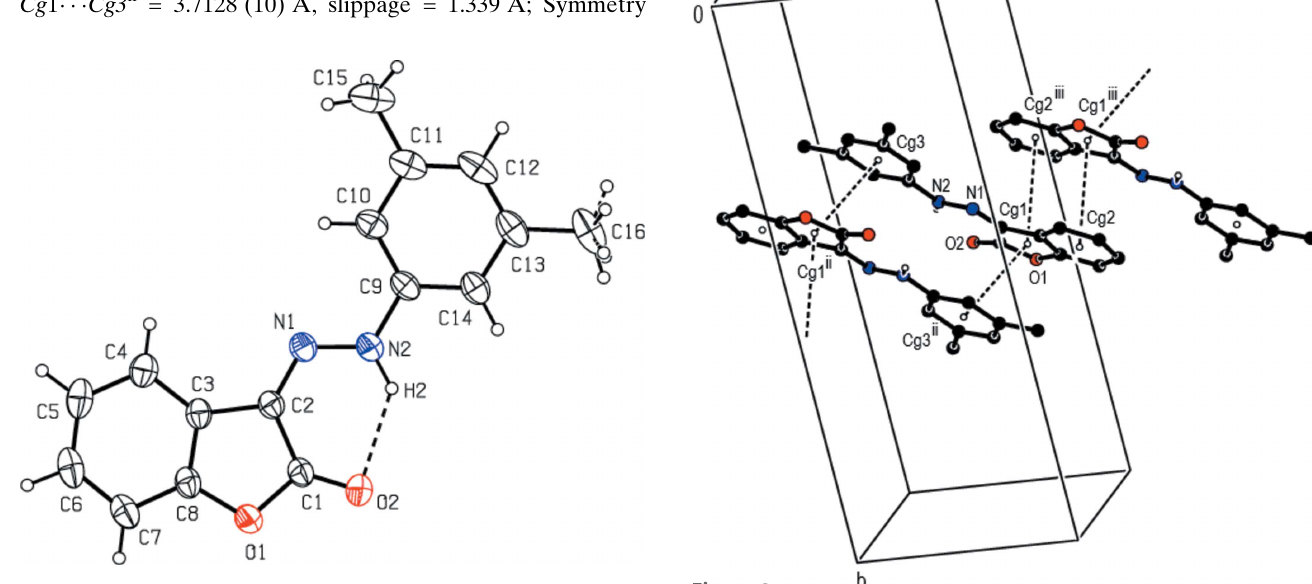
Figure 1 The molecular structure of the title compound with displacement ellipsoids for the non-hydrogen atoms drawn at the 30% probability level.